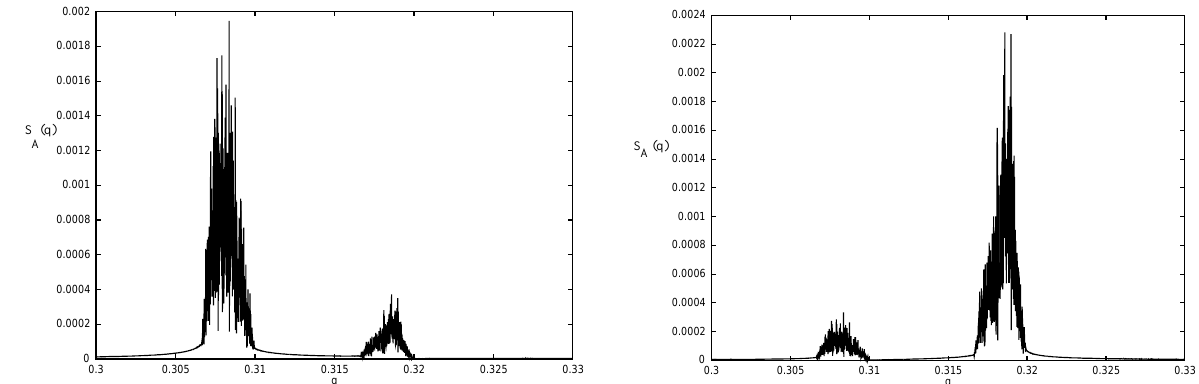
FIG. 11. Beam 2 (left) and beam 1 (right) spectrum of centroid oscillation for head-on collisions with unequal tunes ( Q (cid:2) 1 (cid:3) (cid:1) 0.32 , Q (cid:2) 2 (cid:3) (cid:1) 0.31 ) and initial offset 6 0.1 ( s x ), ( 2 17 turns, N (cid:1) 10 3 macroparticles). Along the horizontal axis we plot the tune, and along the vertical axis the corresponding FFT amplitude. The new coupling modes are inside the continuum and are Landau damped. of beam 2 extends from (cid:2) 0.31 2 j (cid:1) 0.3066 (cid:3) to 0.31,